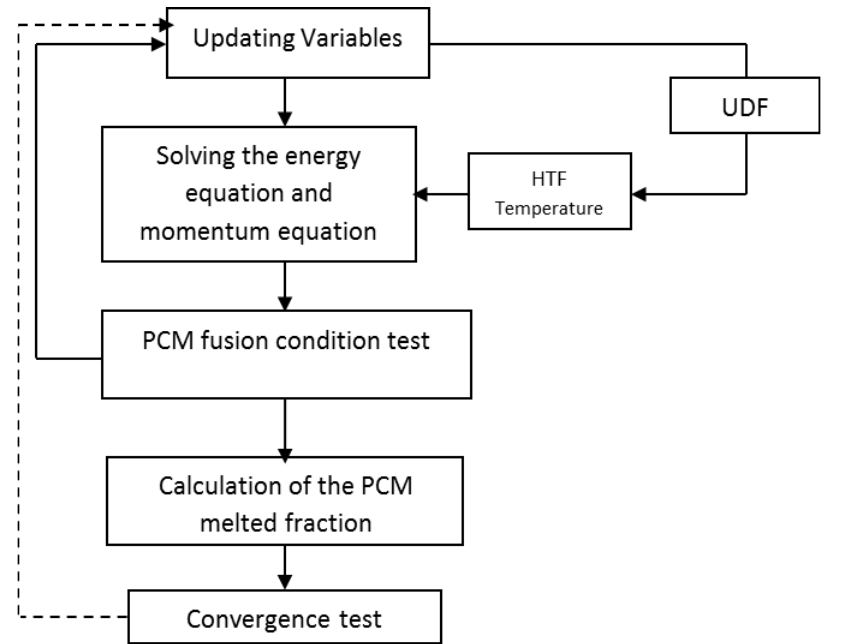
Figure 3. Flowchart showing steps of calculation